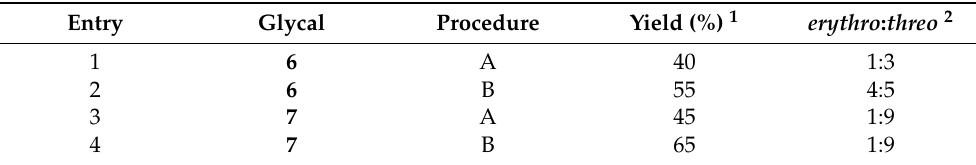
Table 1. Reaction of tributhyltin derivatives of glycals 6 and 7 with aziridinecarboaldehyde 8, according to Scheme